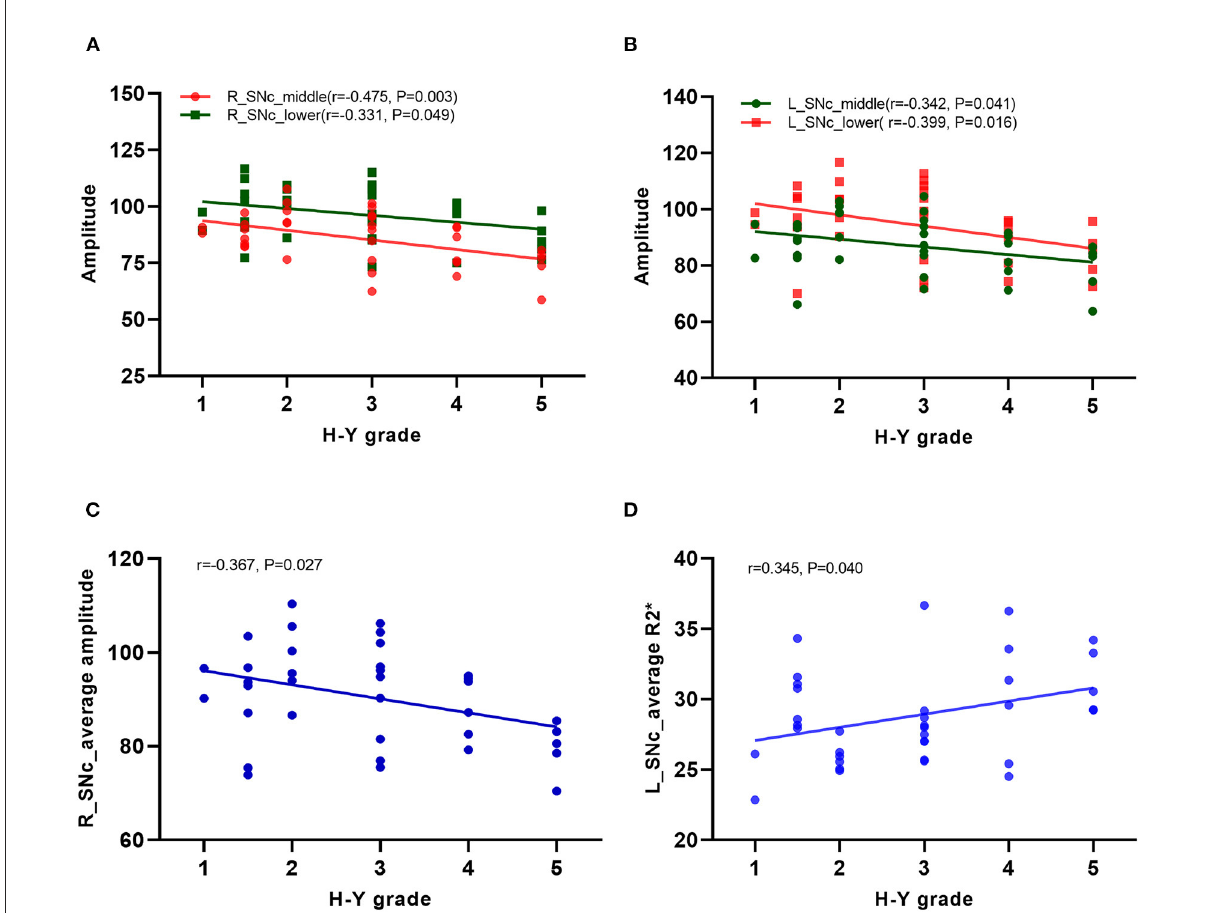
FIGURE5 Correlation analysis in PD patients. (A) Correlation analysis between the amplitudes of the middle and lower parts of the right side of the substation nigra compact zone and H–Y scale; (B) Correlation analysis between the amplitudes of the middle and lower parts of the left side of the substation nigra compact zone and H–Y scale; (C) Correlation analysis between the average amplitude on the right side of the substation nigra compact zone and H–Y scale; (D) Correlation analysis between the the average R2* value on the left side of the substation nigra compact zone and H–Y